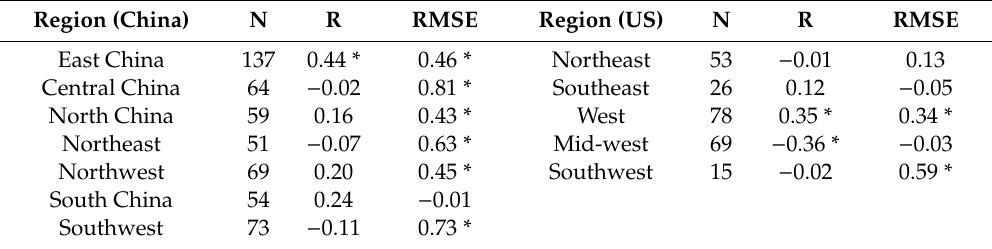
Table 1. Correlation between forecasting accuracy (R and RMSE) and mean PM 2.5 concentration levels across distinct regions in China and United States (US). N denotes the number of sites in each region of interest. The geographic location of each region of interest can be found in Figures S1–S2 in the Supplementary